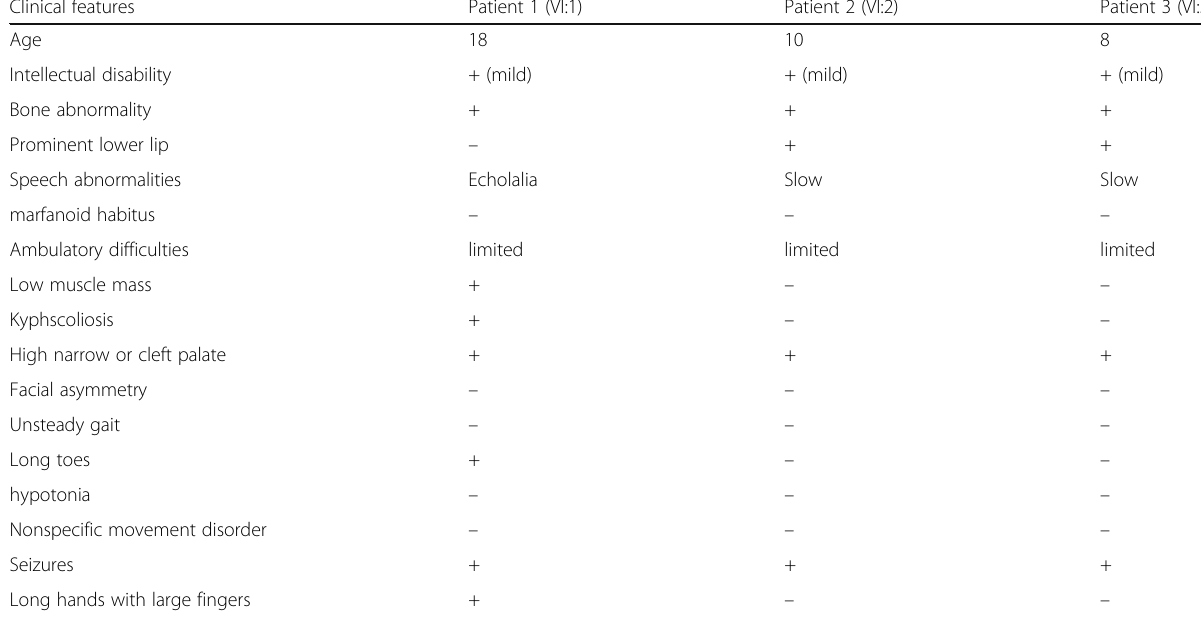
Table 1 Clinical representation of affected individuals in family Clinical